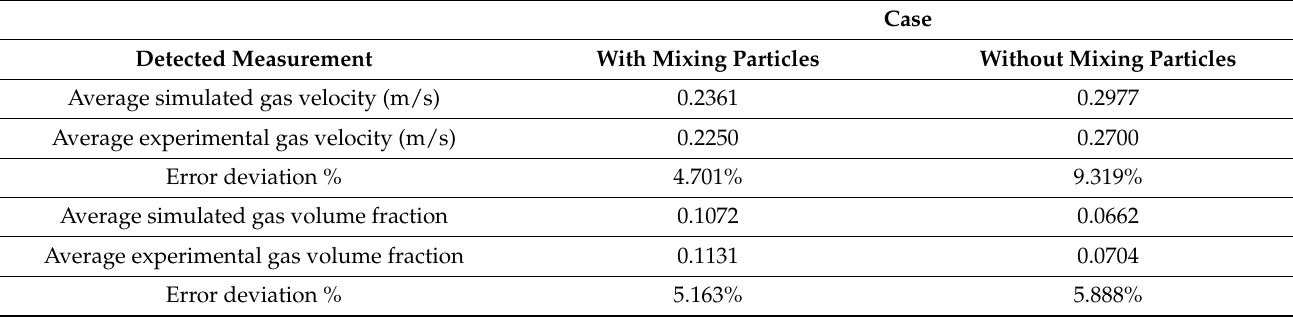
Table 6. Experimental and simulated average gas velocity and volume fraction with and without mixing particles and calculated error deviation (5–10%).